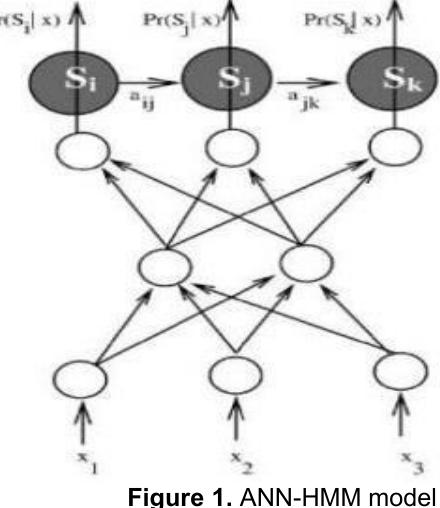
Figure 1. ANN-HMM